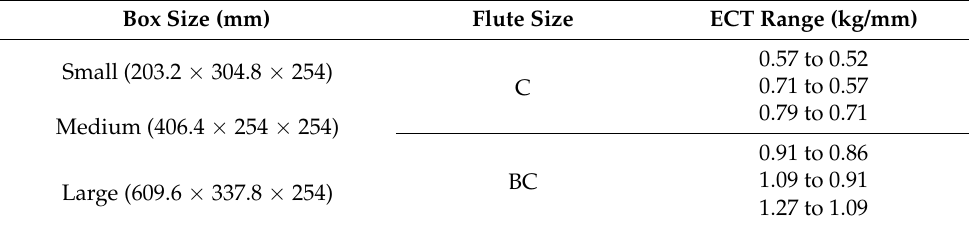
Table 2. Summary table of variable factors related to corrugated